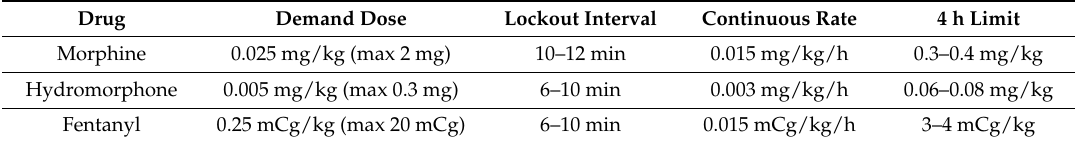
Table 4. Intravenous patient controlled analgesic starting dose recommendations.